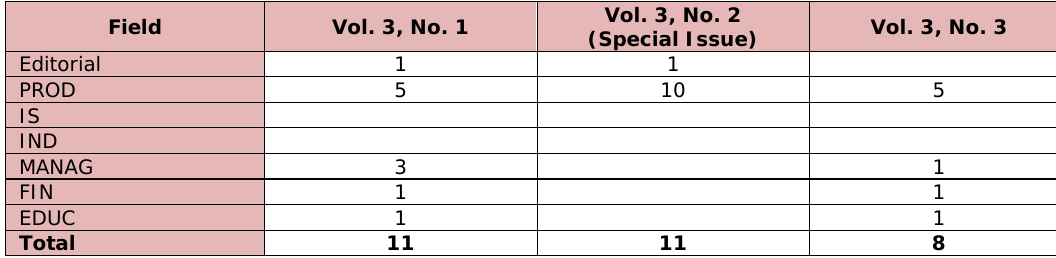
Table 1: Papers published in each field and issue (Volume 3) of JIEM. Source: Editors.